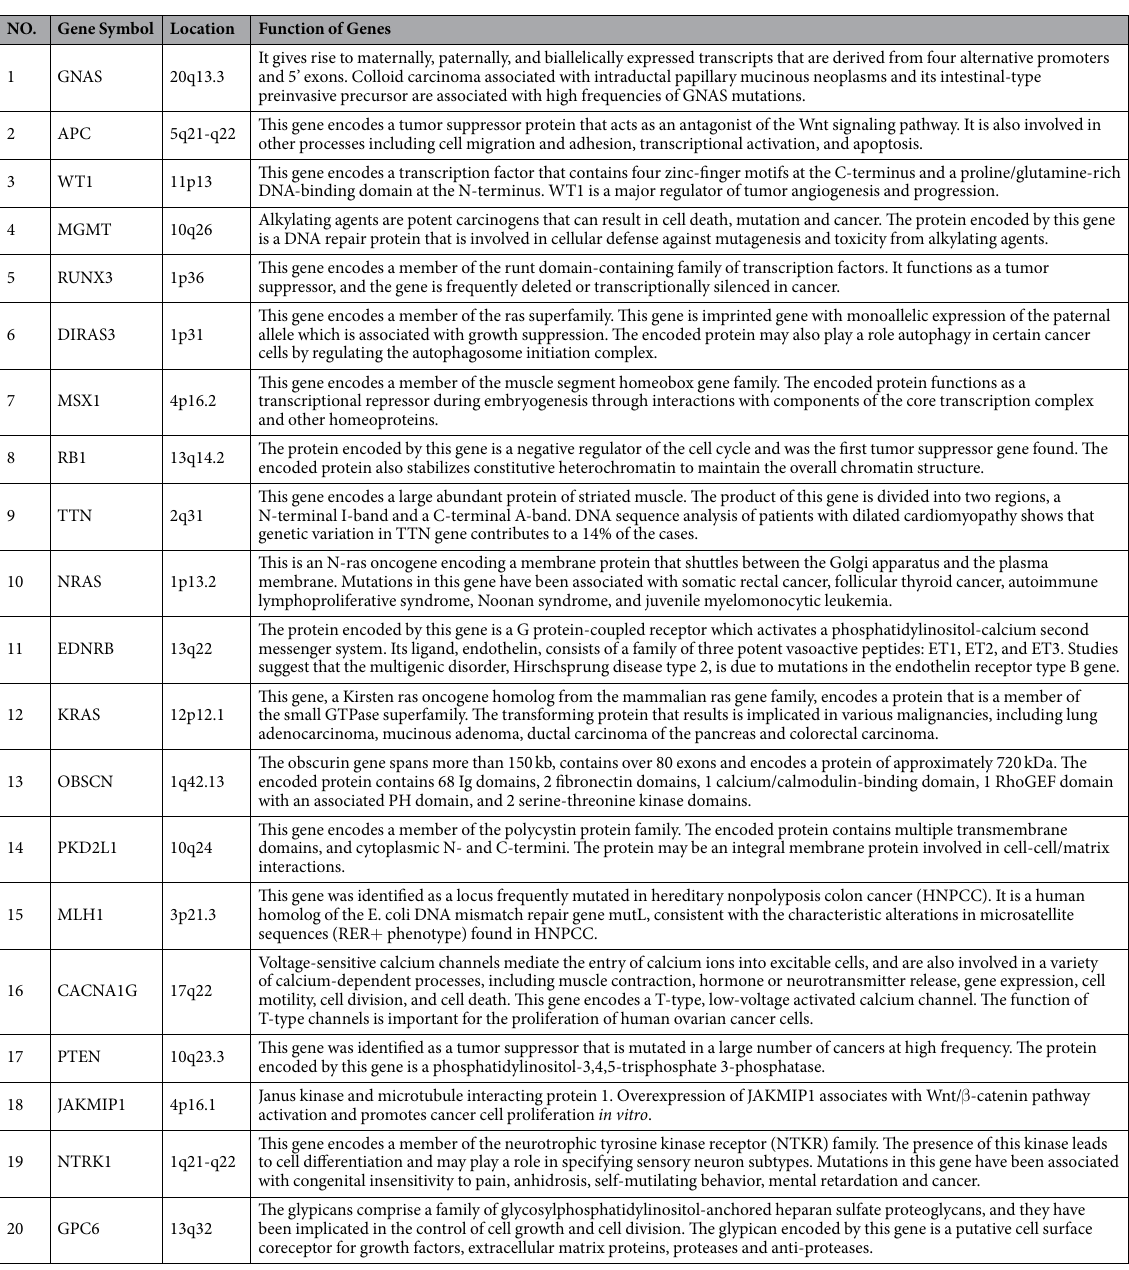
Table 3. The detailed information of the top 20 genes identified by